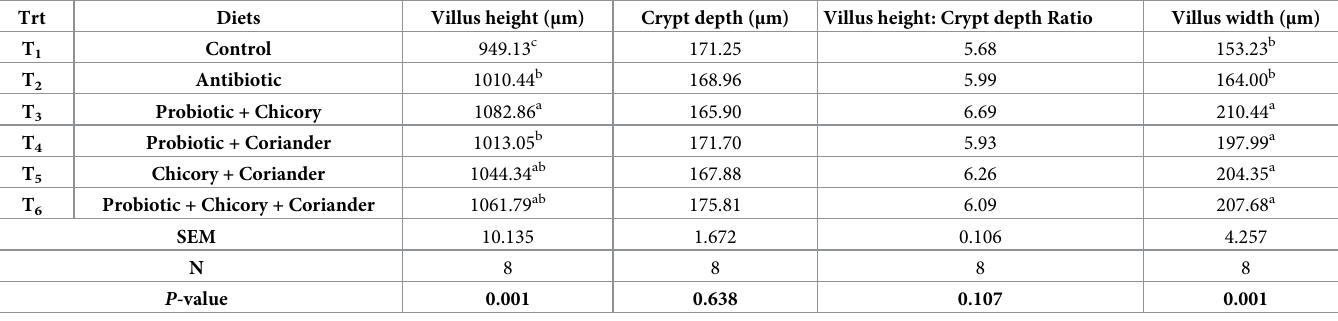
Values bearing different superscripts within a column are significantly (P < 0.05)